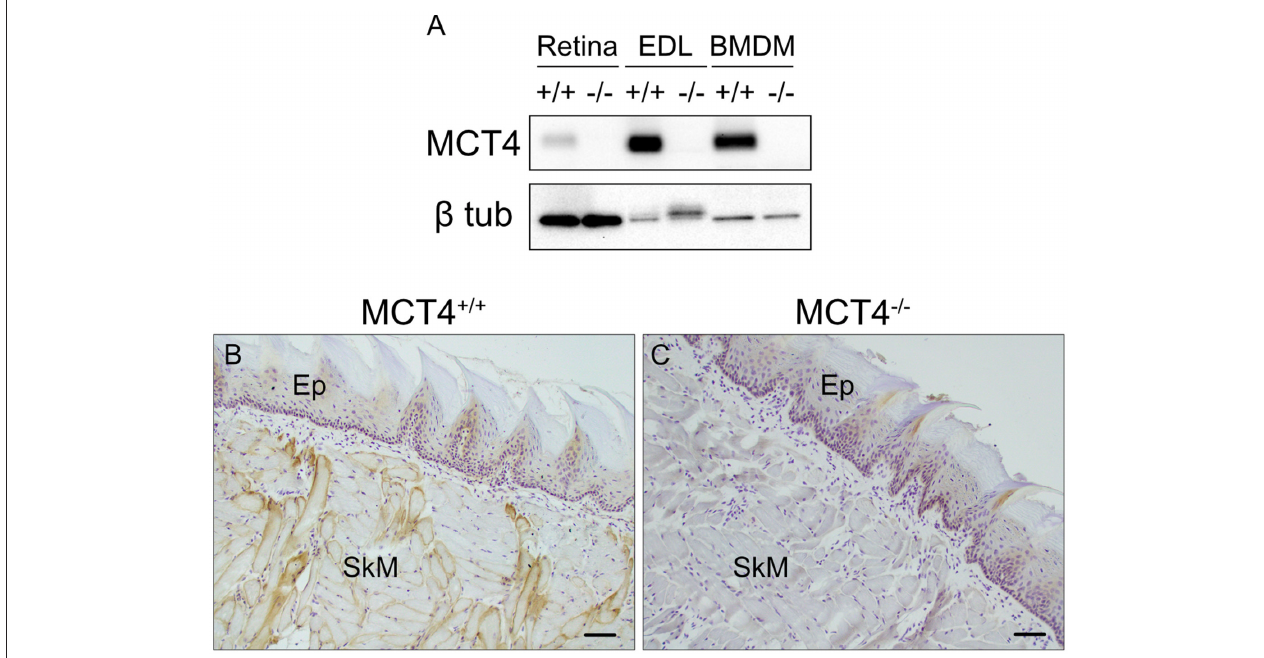
FIGURE 2 | Characterization of MCT4 − / − animals. Western blot of detergent lysates prepared from retinas, extensor digitorum longus (EDL) muscle, and LPS activated bone marrow derived macrophages (BMDM) from wild type ( + / + ) and MCT4 knock out (-/-) mice (A) . Frozen sections of mouse tongue from MCT4 ( + / + ) (B) and MCT4 − / − (C) mice labeled with MCT4 antibody. Ep, epithelium; SkM, skeletal muscle. Scale bar, 50 µ